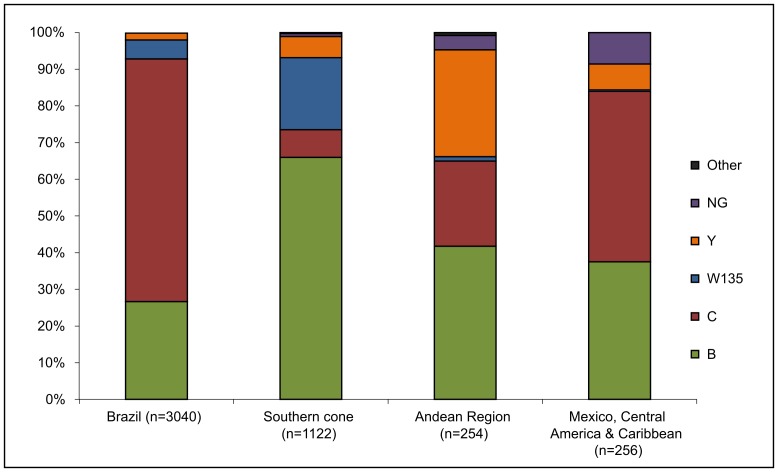
Serogroup distribution, by region for the 2006–2010 period.